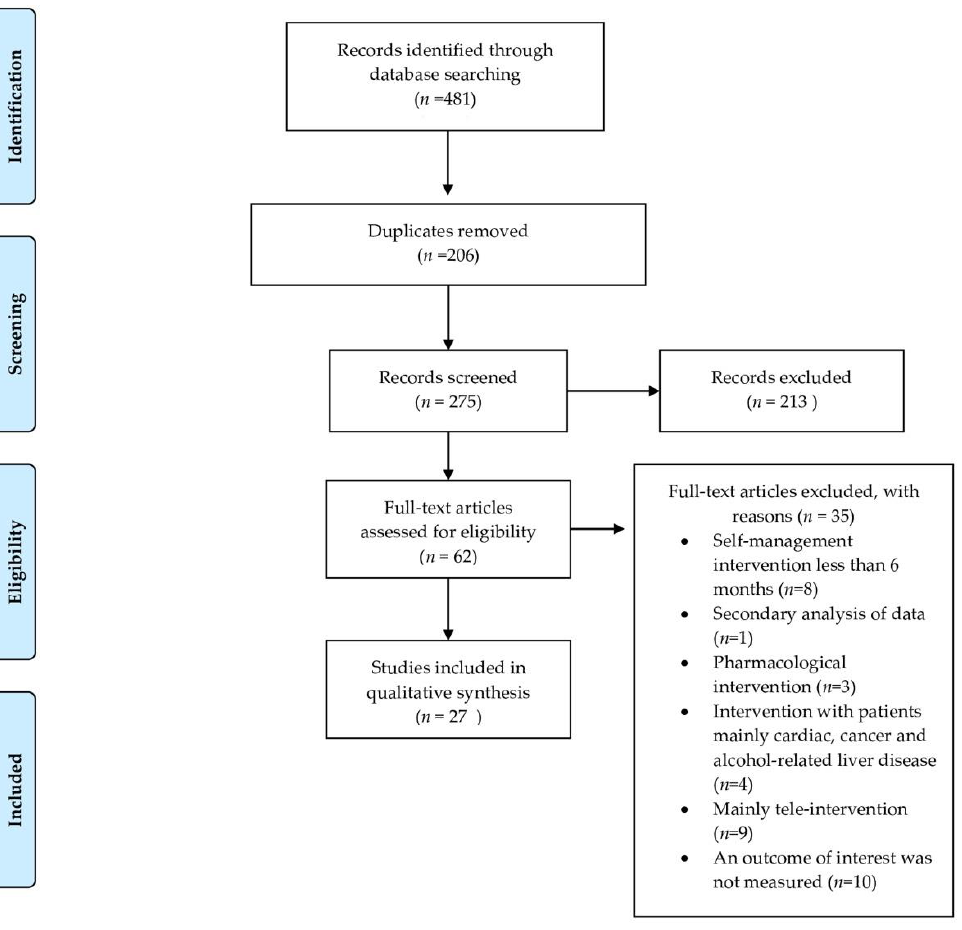
Figure 1. Flow diagram of screening